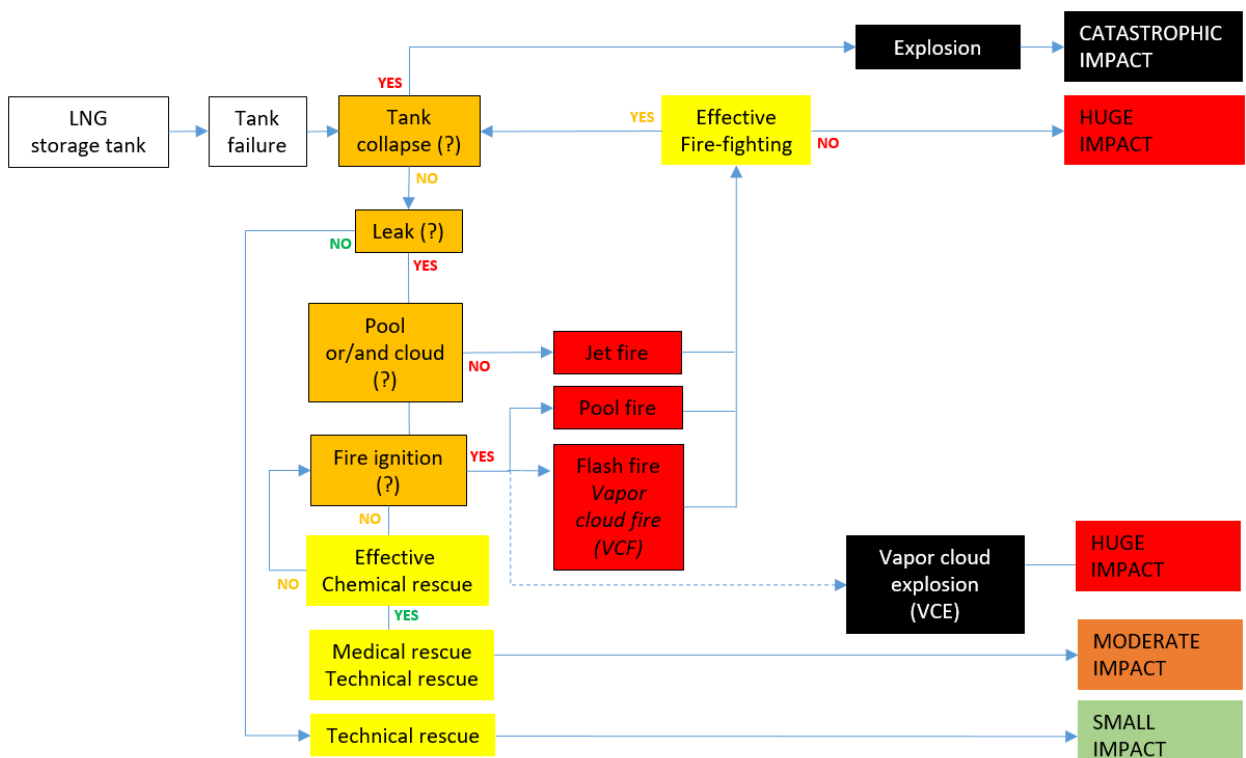
Figure 2. LNG conventional event tree for a storage tank.